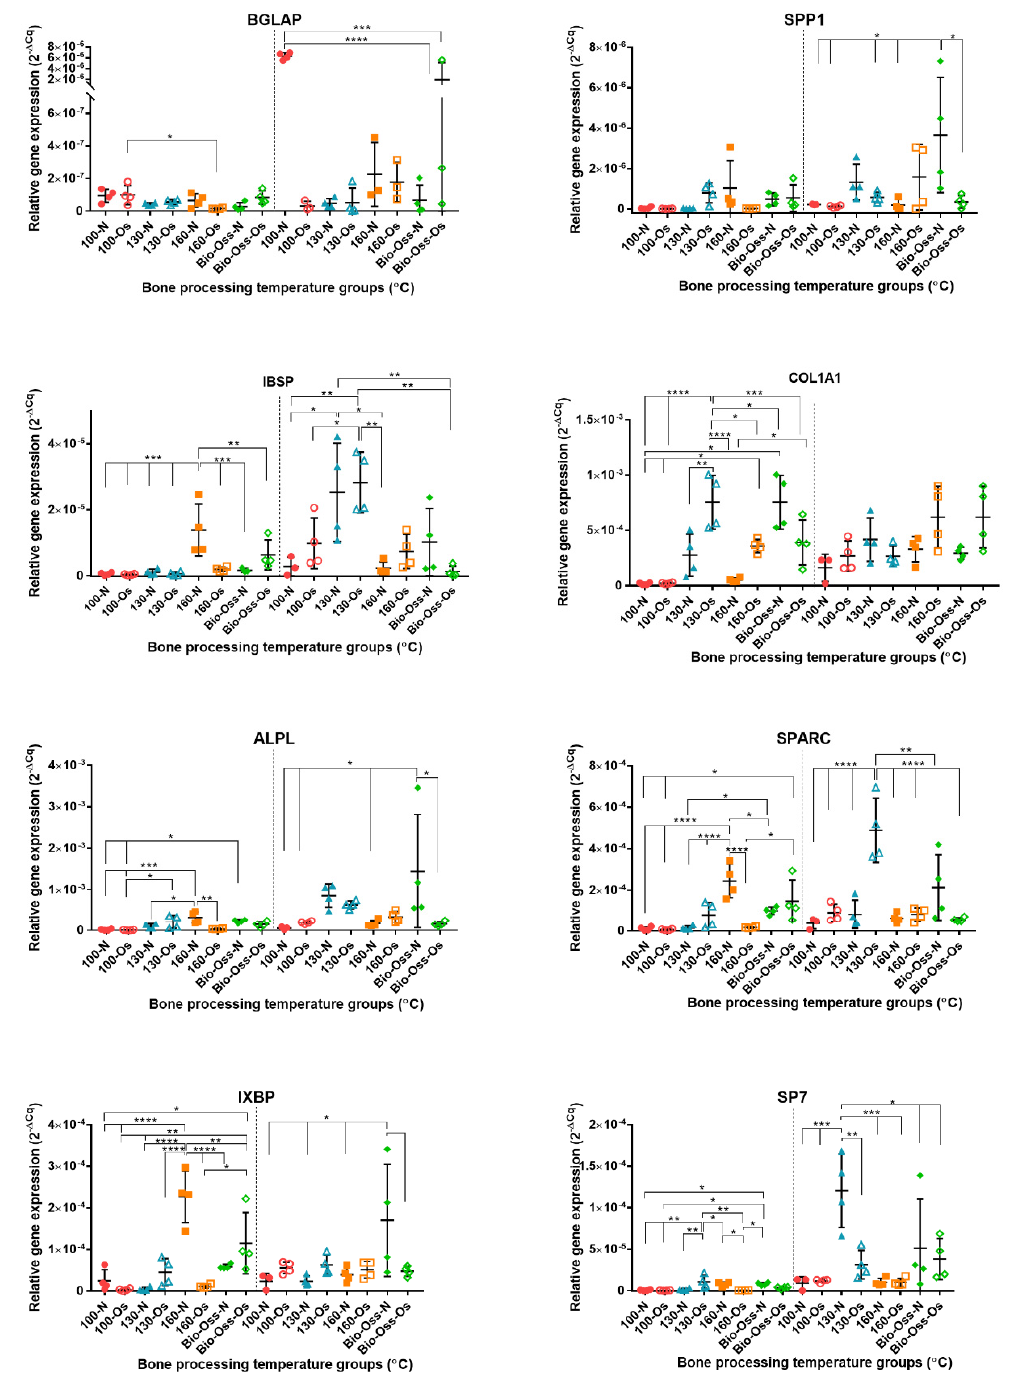
Figure 8. Relative qRT2 − PCR gene expression of genes of interest in osteoblasts cultured on bone processed at different temperatures. The dashed line indicates 7 − day expression on the left of the axis and 21 − day expression on the right of the axis. N = 4. Results expressed as mean ± SD. Significant values * p ≤ 0.05, ** p ≤ 0.01, *** p ≤ 0.001, **** p ≤ 0.0001.